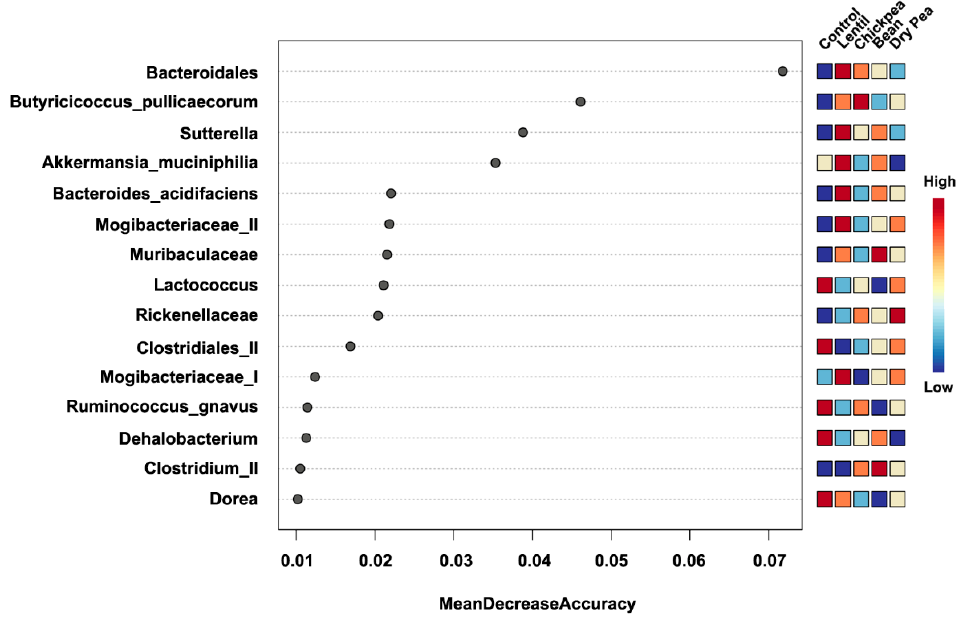
Figure 5. Top 15 bacteria to discriminate between the diet groups predicted by the Random Forest algorithm. Features are ranked by their contributions to classification accuracy (Mean Decrease Accuracy). Relative abundance per diet group is represented on the heatmap to the right.